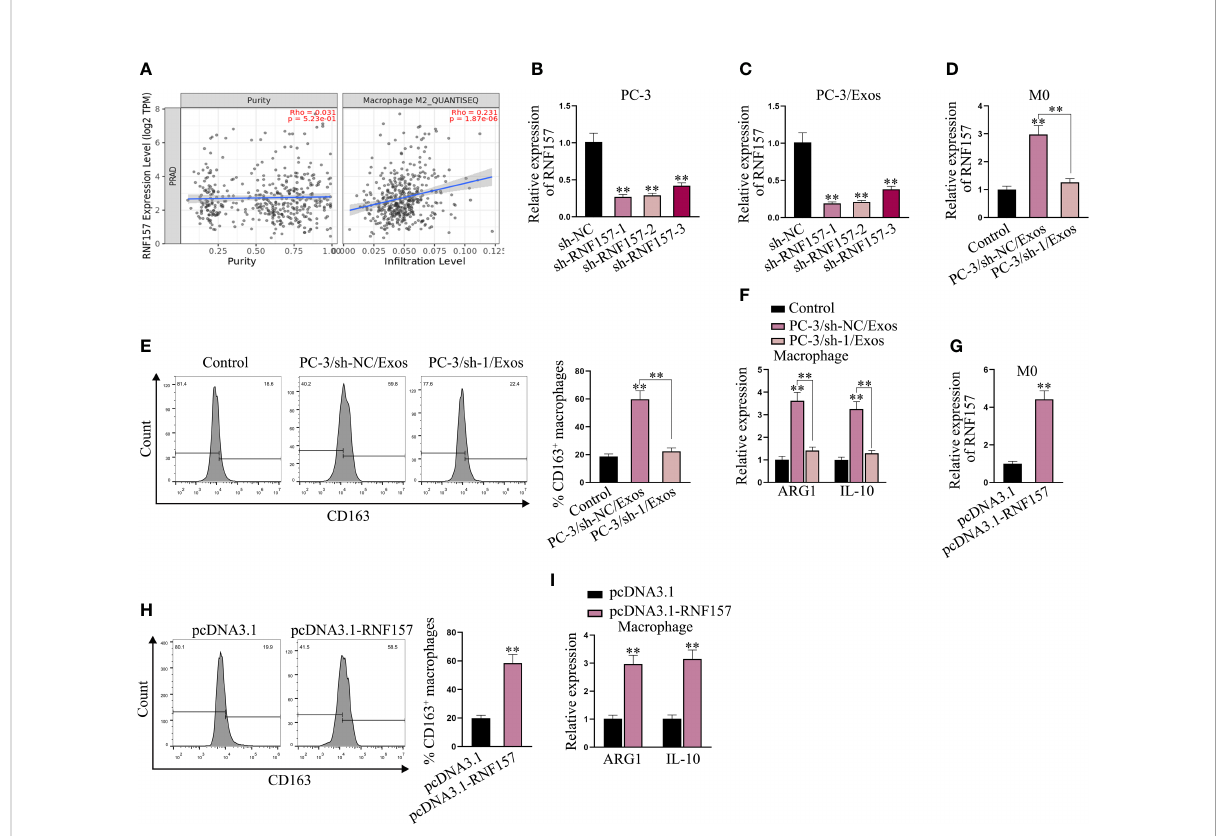
FIGURE 3 Exosomal RNF157 mRNA from PCa cells could induce the M2 polarization of macrophages. (A) TIMER 2.0 predicted the correlation between RNF157 expression in PRAD and M2 macrophage in fi ltration. (B) RNF157 was knocked down in PC-3 cells by transfection of sh-RNF157. (C) RNF157 mRNA level in exosomes from RNF157-depleted PC-3 cells was detected via RT-qPCR. (D) RNF157 mRNA level in macrophages after co-culture with exosomes from sh-NC or sh-RNF157 transfected PC-3 cells was tested through RT-qPCR. (E) Flow cytometry analyzed the percent of CD163-positive macrophages. (F) RT-qPCR analyzed ARG1 and IL-10 levels in macrophage after co-culture with different exosomes. (G) RT-qPCR the RNF157 level in macrophages after transfection of pcDNA3.1-RNF157. (H, I) Flow cytometry analysis of CD163 positivity and RT-qPCR analysis of ARG1 and IL-10 levels assessed M2 polarization rate before and after RNF157 augment. **P <